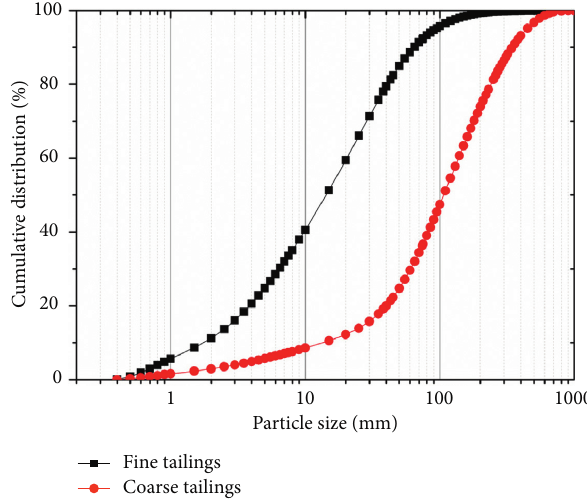
Figure 1: Grain size distribution of coarse and fine